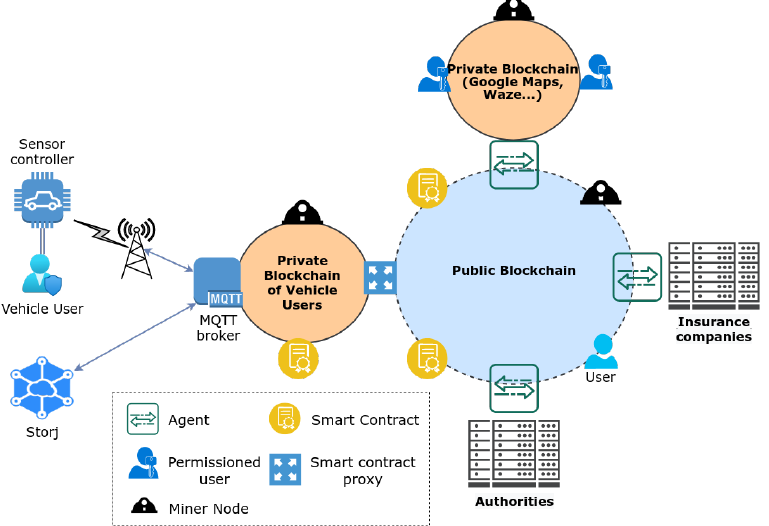
Figure 1. An architecture for security and privacy in mobile IoT